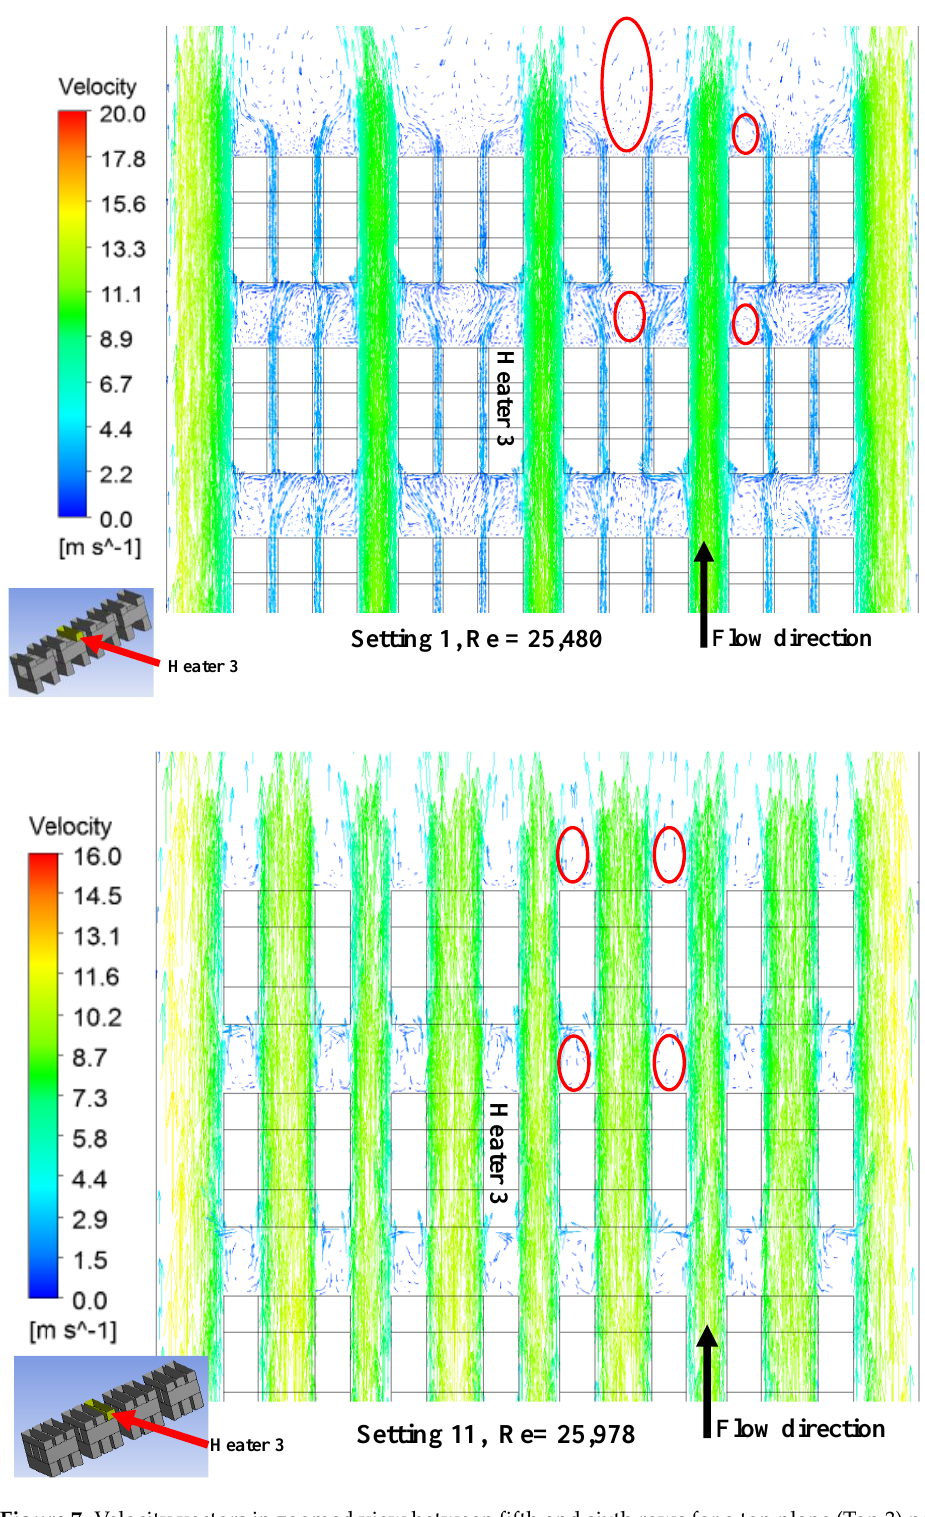
Figure 7. Velocity vectors in zoomed view between fifth and sixth rows for a top plane (Top 3) passing through heater 3.